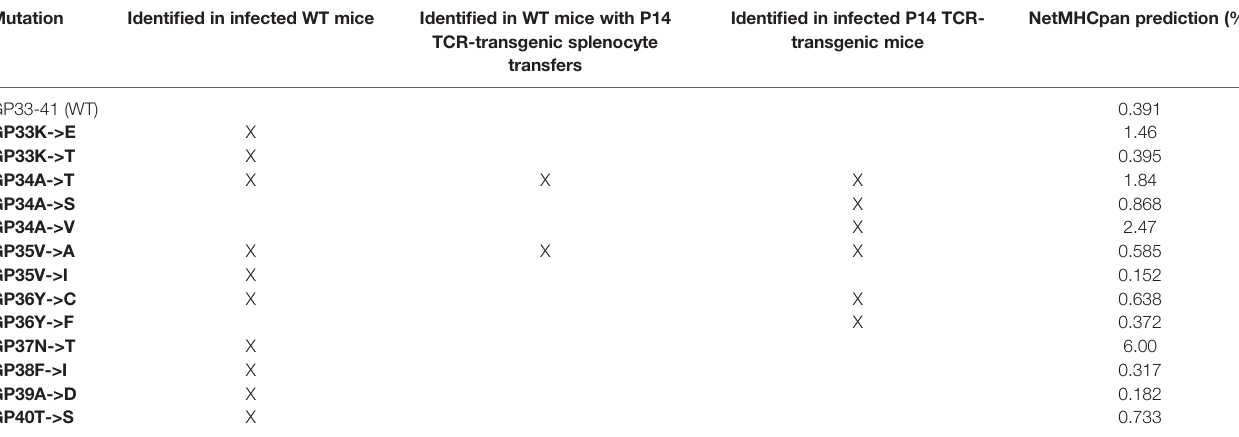
The predictions are the percentage rank scores calculated using the netMHCpan (v.4.0) prediction